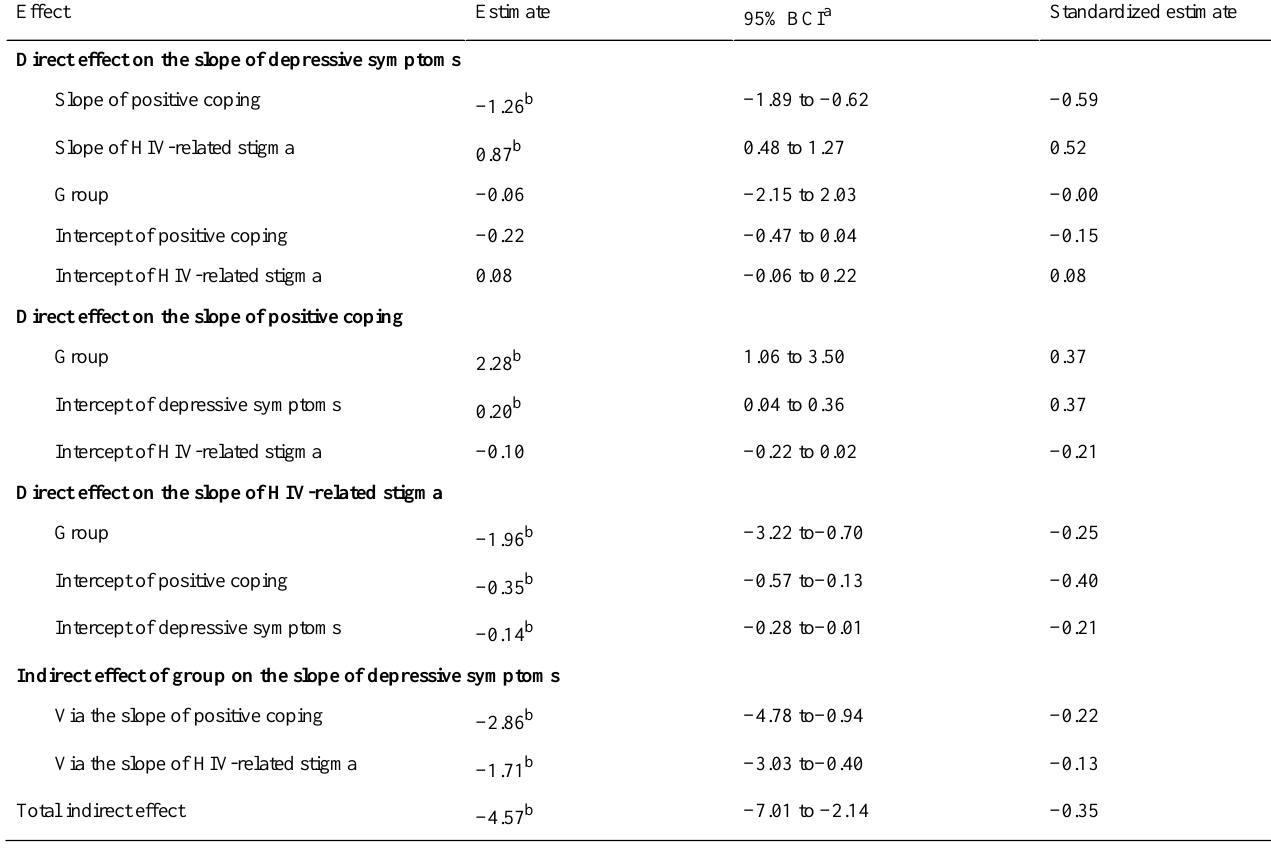
Table 4. Coefficients and bootstrapping CIs of the final parallel-process latent growth curve